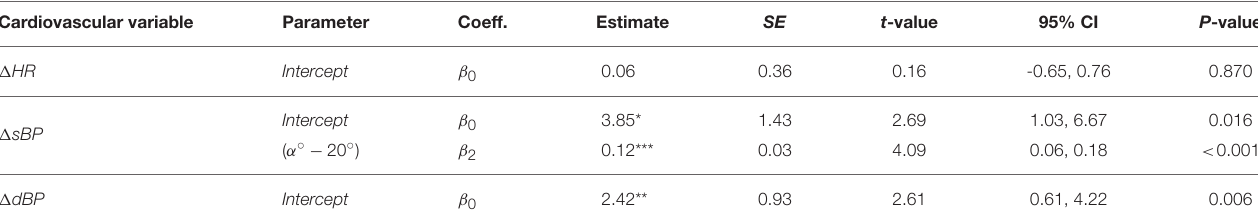
TABLE 2 | Statistical models for 1 HR, 1 sBP, and 1 dBP in primary analysis, i.e., consideration of PE effect independent from head-up tilting effect contribution. Cardiovascular variable Parameter